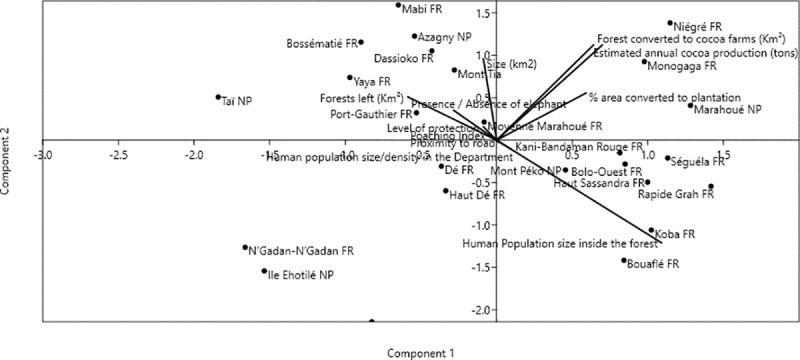
Biplot of principal coordinate analysis of the presence of forest elephants in 25 PAs correlated with environmental variable (size of the forest, percentage of area converted into plantation, size of the forest left, size of human population inside the PA, poaching index, distance to the nearest road, population density in the Department, level of protection of the PA).Coordinates 1 and 2 explain 70% of variation in the data.